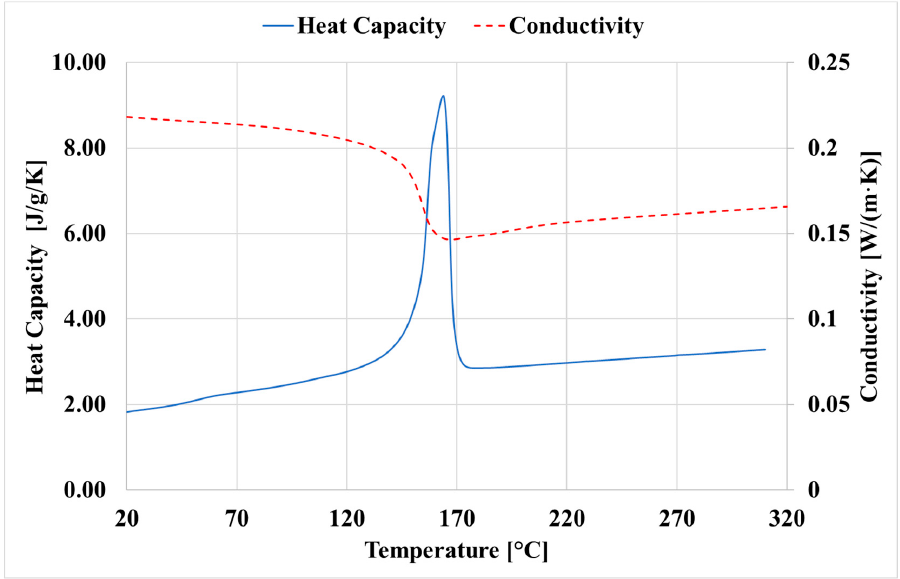
Figure 6. Measured heat capacity and conductivity depending on the temperature.